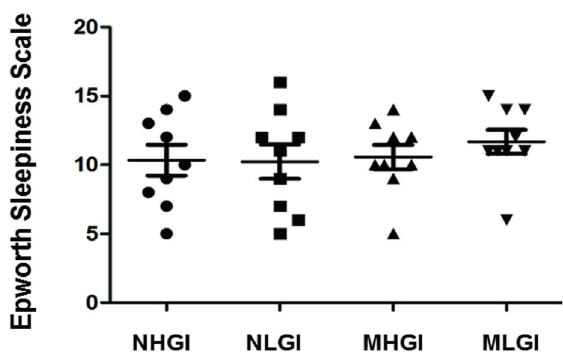
Figure 2 - Daytime sleepiness according to the moments (N=night and M=morning) and GI of the meals (HGI=high glycemic index and LGI=low glycemic index) (n=9).